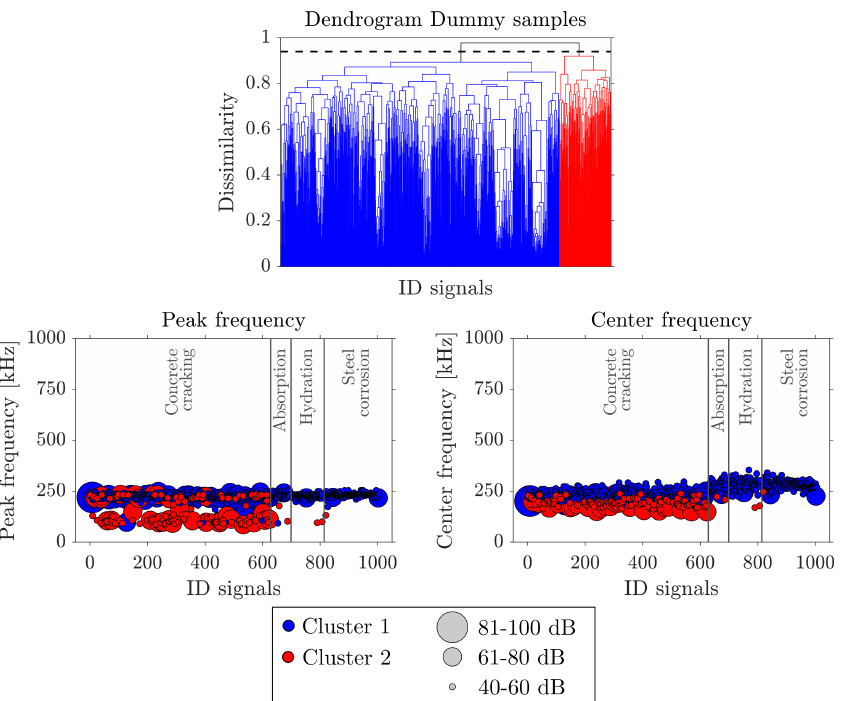
Figure 3. Results of the clustering algorithm performed on dummy samples with ( top ) dendrogram, ( bottom left ) peak frequency versus ID number of the AE signals, and ( bottom right ) center frequency versus ID number of the AE signals. The size of the dots depends on the amplitude (in dB) of the AE signal. Expected AE sources are indicated for each group of signal